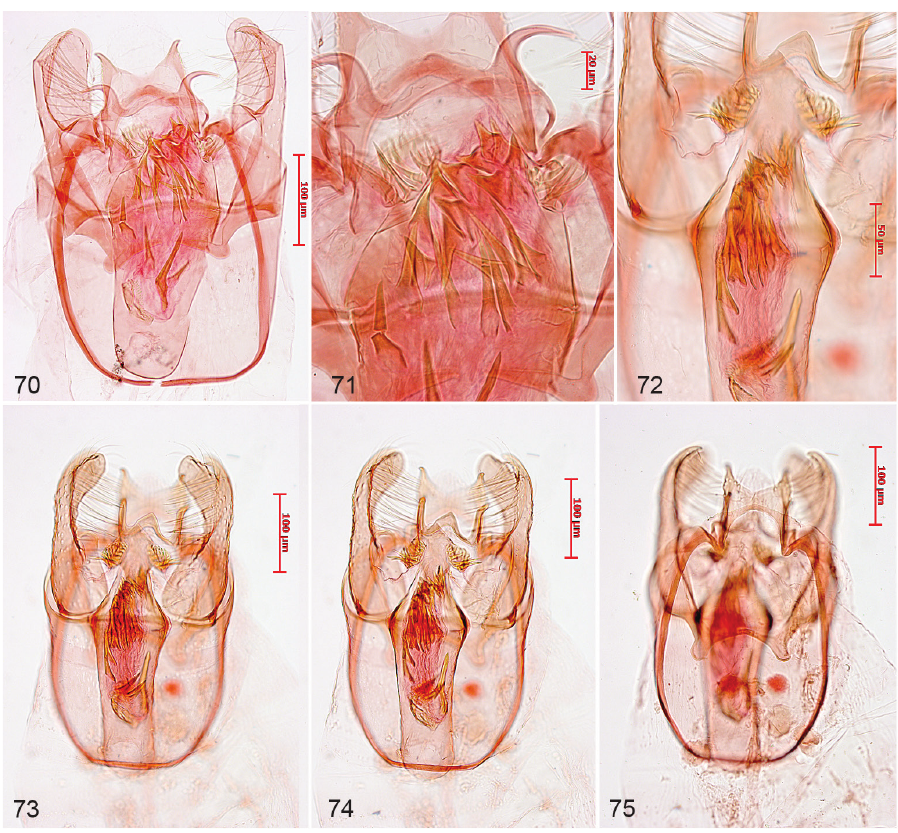
24 Stigmella wollofella (Gustafsson, 1972). Study of the slides of the holotypes of Nep- ticula wollofella Gustafsson, 1972 (Figs 72–75) and N. mandingella